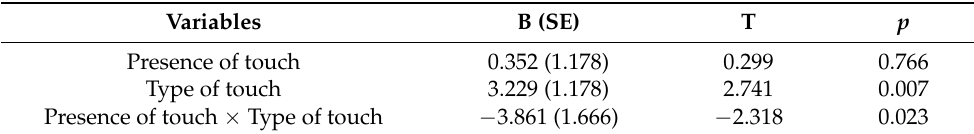
Table 4. Summary of the most plausible-fitting model predicting RMSSD.